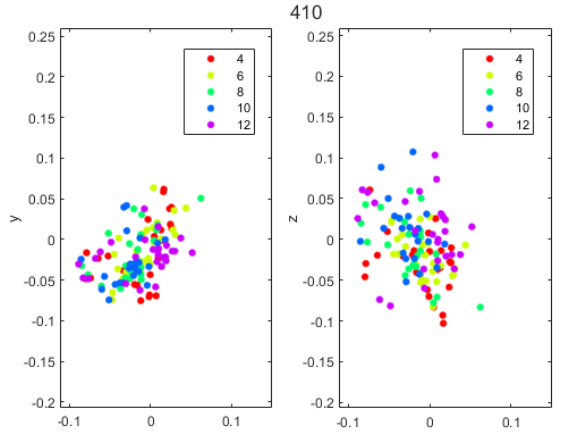
Figure 11. Scatter plot of the residuals for benchmark 410, for all the operators and all the considered rover-façade distance values.